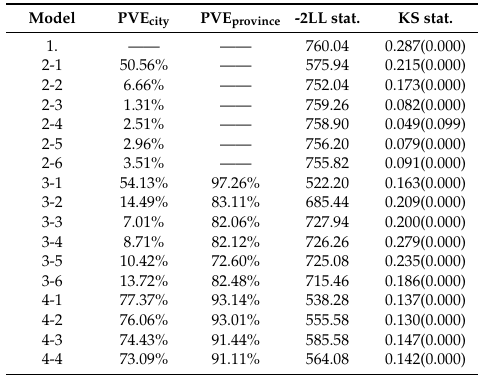
Table 7. Variance explained by the models and their statistical